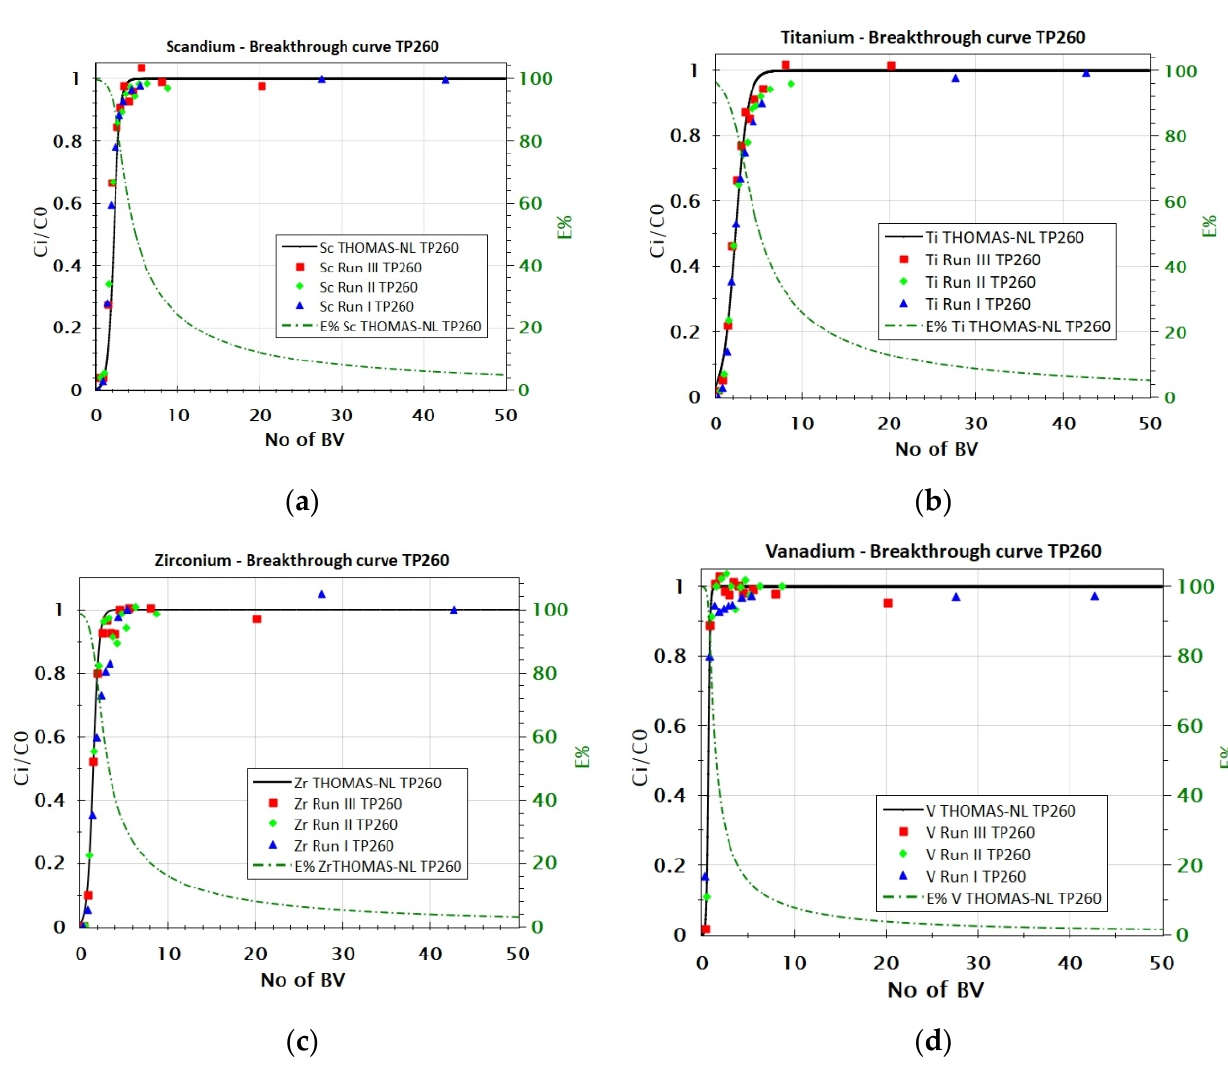
Figure 3. Extraction and breakthrough curves for TP 260 resin for ( a ) Sc, ( b ) Ti, ( c ) Zr, and ( d ) V were measured in three different experimental runs and their Thomas nonlinear (NL) prediction mathematical model.